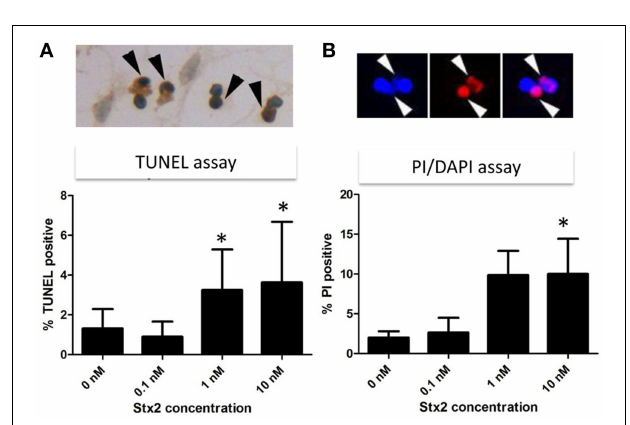
FIGURE 4 | Stx2 induces apoptotic cell death in vitro . Neurons were incubated with different concentrations of Stx2 for 48h and assayed with TUNEL stain ( n = 20 /group) (A) and propidium idodide (PI)/DAPI stain ( n = 5 /group) (B) . TUNEL positive nuclei (dark brown, black arrowheads) numbers were normalized by counter stained total nuclei numbers and expressed as percent TUNEL positive. In PI/DAPI stain, the percentage of PI positive nuclei (Red, white arrowheads) per total (DAPI positive, blue) nuclei was calculated. One-Way ANOVA followed by Tukey test, ∗ p < 0 . 05